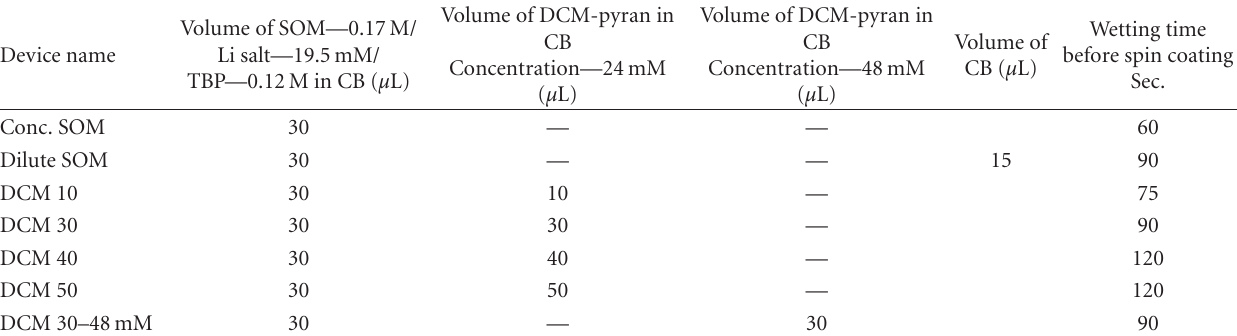
Table 2: Device names and their key fabrication details